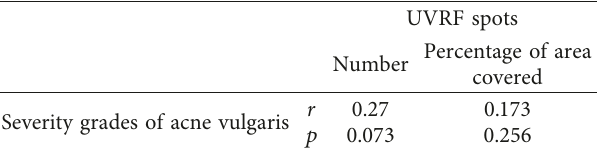
Table 4: Correlation between severity grades of acne vulgaris with UVRF